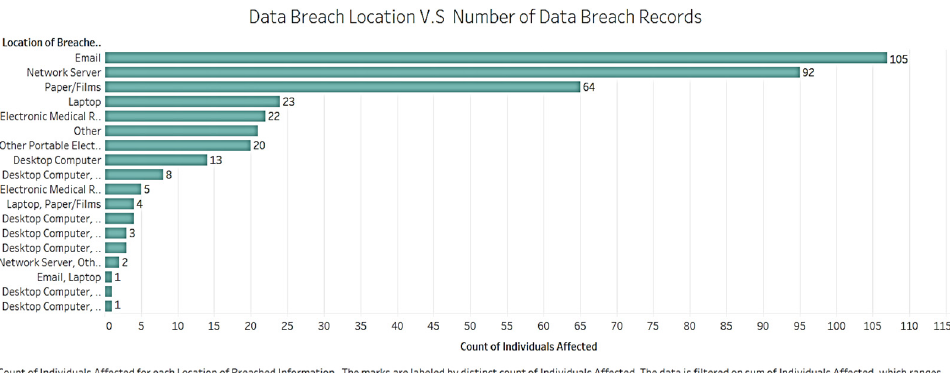
Figure 3. Data breach location vs. number of affected individuals.